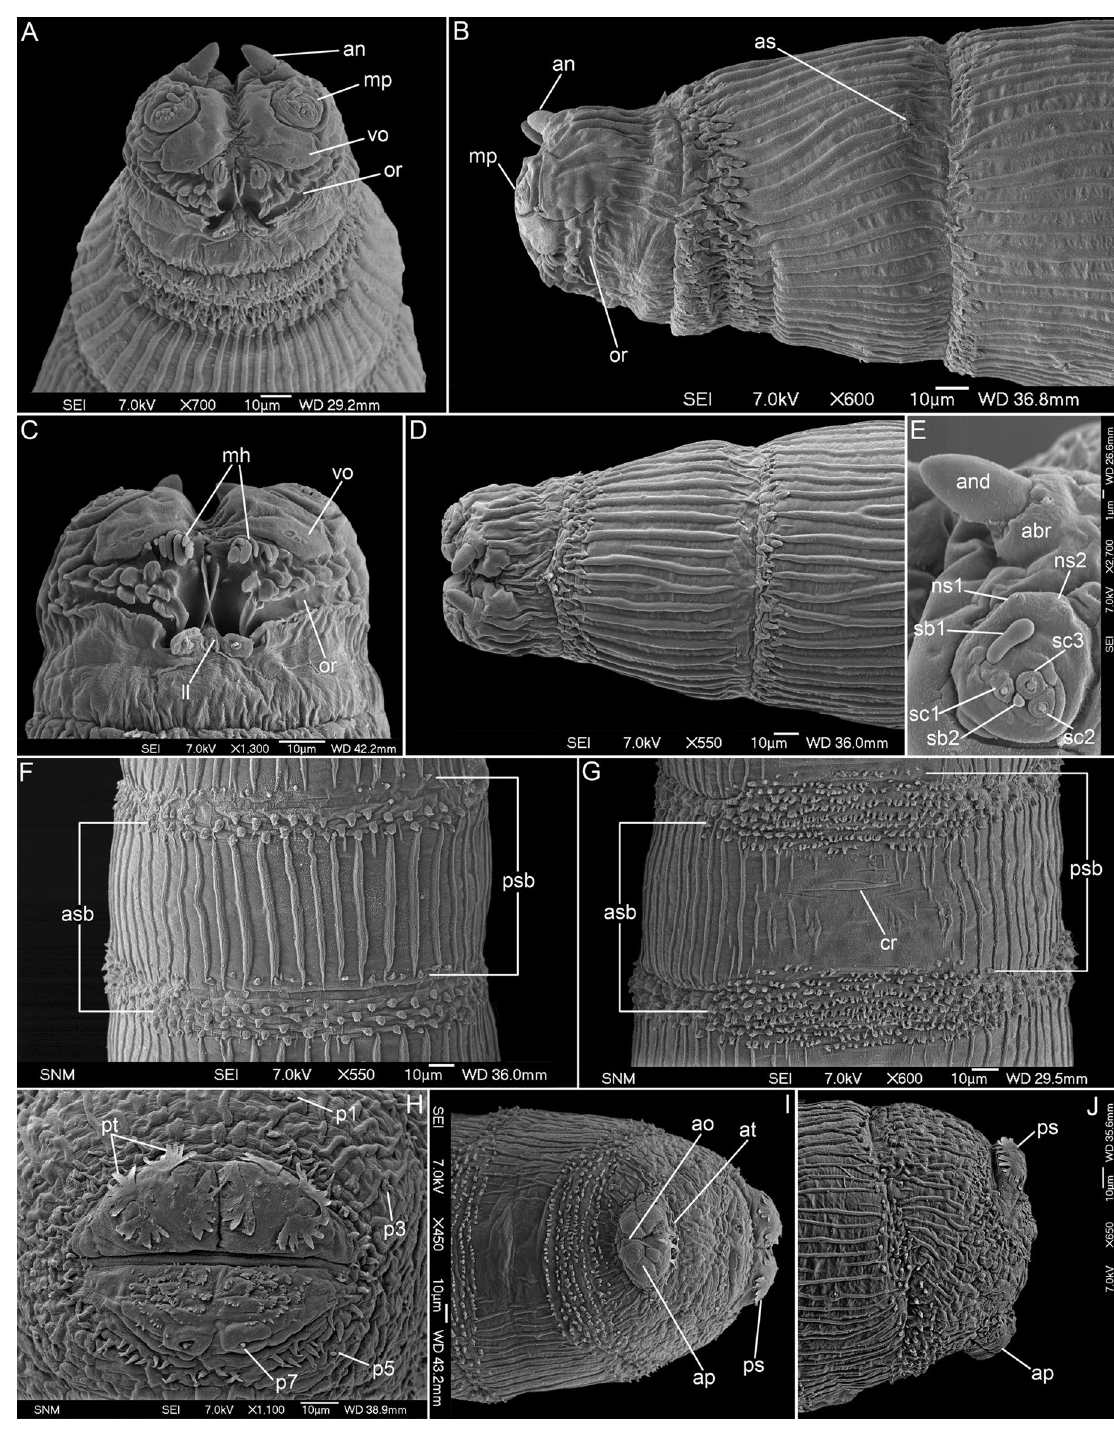
Figure 1. First instar larva of Aenigmetopia amissa . ( A ) Anterior end, ventral view. ( B ) Anterior end, lateral view. ( C ) Pseudocephalon, ventral view. ( D ) Anterior end, dorsal view. ( E ) Antennal complex and maxillary palpus. ( F ) First abdominal segment, dorsal view. ( G ) Second abdominal segment, ventral view. ( H ) Anal division, spiracular field. ( I ) Posterior end, ventral view. ( J ) Posterior end, lateral view. abr, antennal basal ring; an, antennal complex; and, antennal dome; ao, anal opening; ap, anal papilla; as, anterior spiracle; asb, anterior spinose band; at, anal tuft; cr, transverse crevice; ll, labial lobe; mh, mouthhook; mp, maxillary palpus; ns1, first additional sensillum coeloconicum; ns2, second additional sensillum coeloconicum; or, oral ridges; p1–p7, papillae around spiracular field; ps, posterior spiracle; psb, posterior spinose band; pt, peristigmatic tufts; sb1–3, sensilla basiconica 1–3; sc1–3, sensilla coeloconica 1–3; vo, ventral